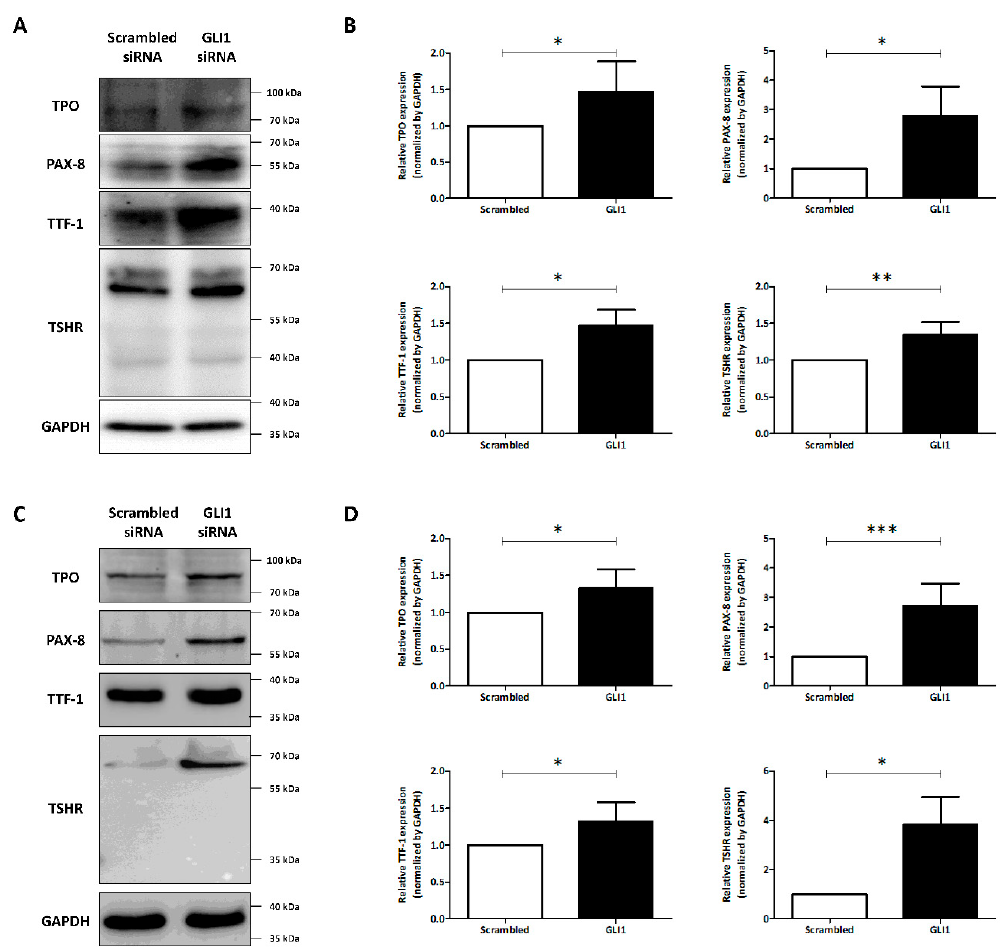
Figure 3. Evaluation of the expression of thyroid-specific proteins and transcription factors in thyroid cancer-derived cells with GLI1 knockdown. Both TPC-1 and SW1736 cells were treated with scrambled siRNA or GLI1 siRNA for 48 h and changes in the expression of thyroid-specific proteins were evaluated. ( A ) Western blot analysis showing expression of thyroid-specific proteins (thyroperoxidase (TPO) and TSH receptor (TSHR)) and transcription factors (PAX-8 and TTF-1) in TPC-1 cells. ( B ) Quantitative analysis of western blots. GAPDH was used as an internal control. Mean ± SD values from at least three independent experiments are reported. * p < 0.05, ** p < 0.01 (Student’s t test). ( C ) Changes of thyroid-specific proteins and transcription factors expression in SW1736 cells with GLI1 knockdown. ( D ) Quantitative analysis of thyroid-specific proteins and transcription factors expression in SW1736 cells. Mean ± SD values from at least three independent experiments are presented. * p < 0.05, *** p < 0.001 (Student’s t test). Raw data is presented in Figures S11–S14.